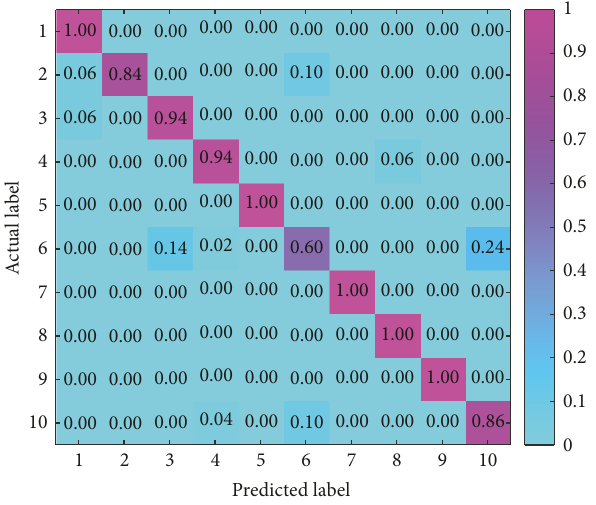
Figure 6: Multiclass confusion matrix of the proposed method for the second trial.